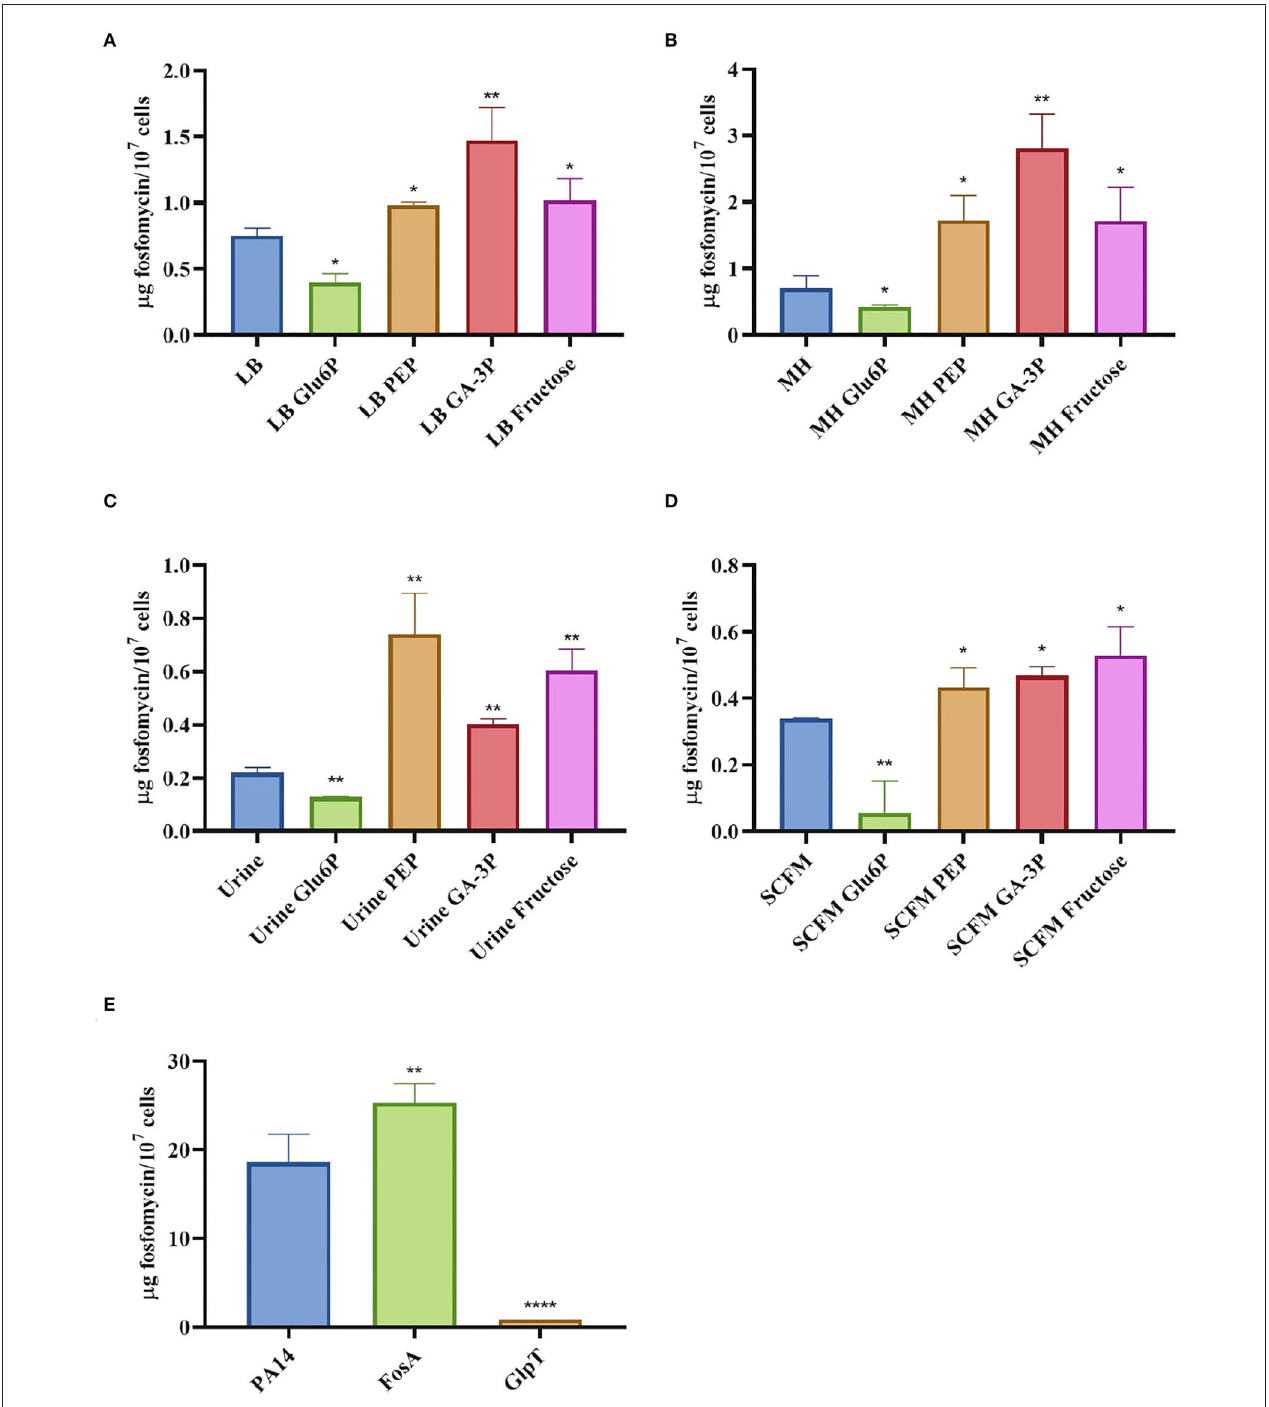
FIGURE 2 | Intracellular concentration of fosfomycin in S. maltophilia D457 changes in the presence of different metabolites and under different growing conditions. The figure shows the fosfomycin intracellular concentration when S. maltophilia D457 grows under different conditions and the effect of glucose-6-phosphate (Glu6P), PEP, glyceraldehyde-3-phosphate (GA-3P), and fructose in said accumulation. As shown, there is a deficiency in the fosfomycin internalization in all media when glucose-6-phosphate is added, as well as a better internalization of the antibiotic in the presence of PEP, GA-3P, and fructose in LB (A) , MH (B) , urine (C) , and SCFM (D) . As control, the intracellular fosfomycin concentration was measured in P. aeruginosa PA14 wild-type strain and two isogenic mutants, one lacking the fosfomycin inactivating enzyme FosA and another one lacking the fosfomycin transporter GlpT. As shown, the absence of FosA allows higher fosfomycin accumulation, whereas the mutant lacking GlpT accumulates less antibiotic (E) , results that validate the reliability of the methodology. Error bars indicate standard deviations for the results from three independent replicates. Statistical significance estimated using an unpaired two-tailed t -test: * P < 0.01; ** P < 0.001; **** P < 0.0001.